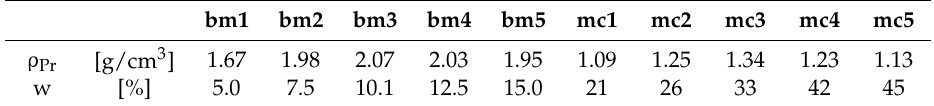
Table 2. Proctor density ( ρ Pr ) and moisture content (w) of the boulder marl (bm) and marsh clay (mc) with 10 soil cores per Proctor stage.